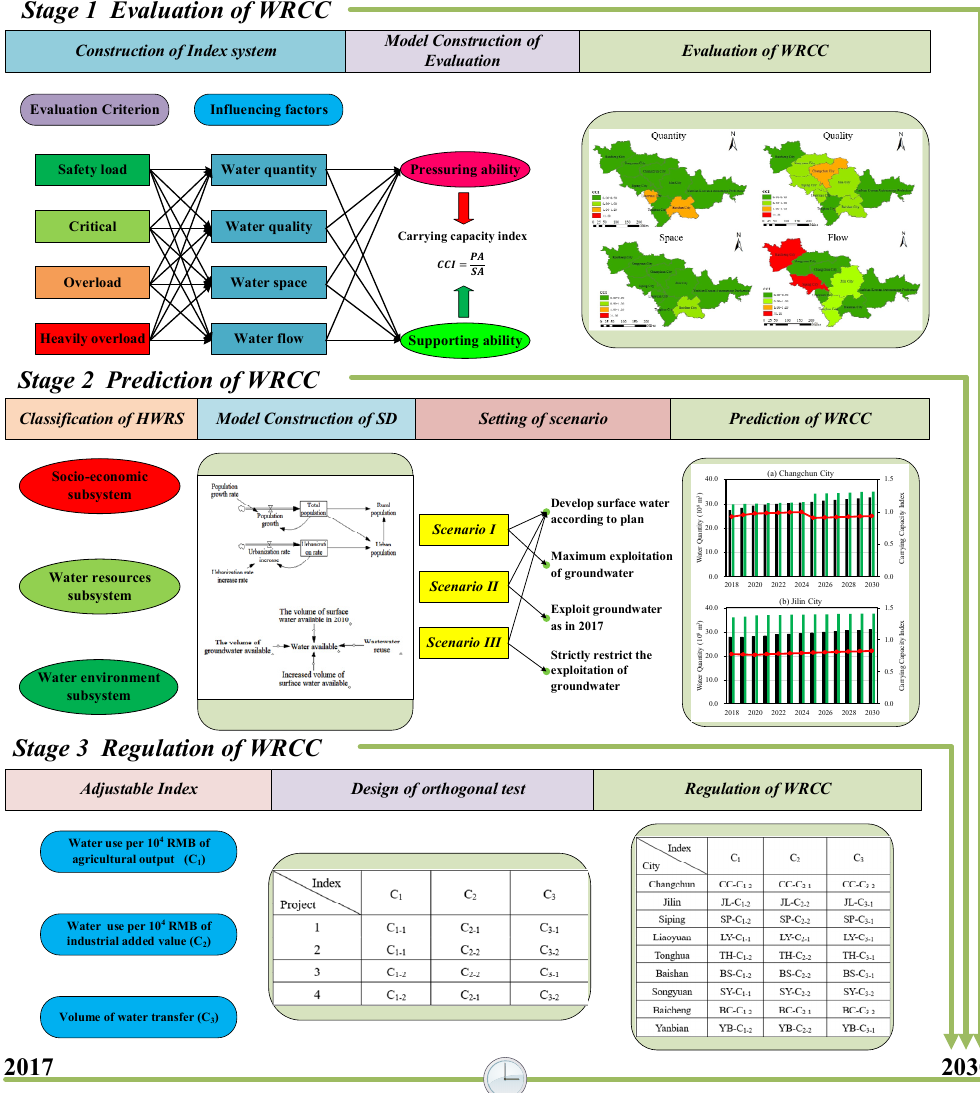
Figure 2. Framework of this work.